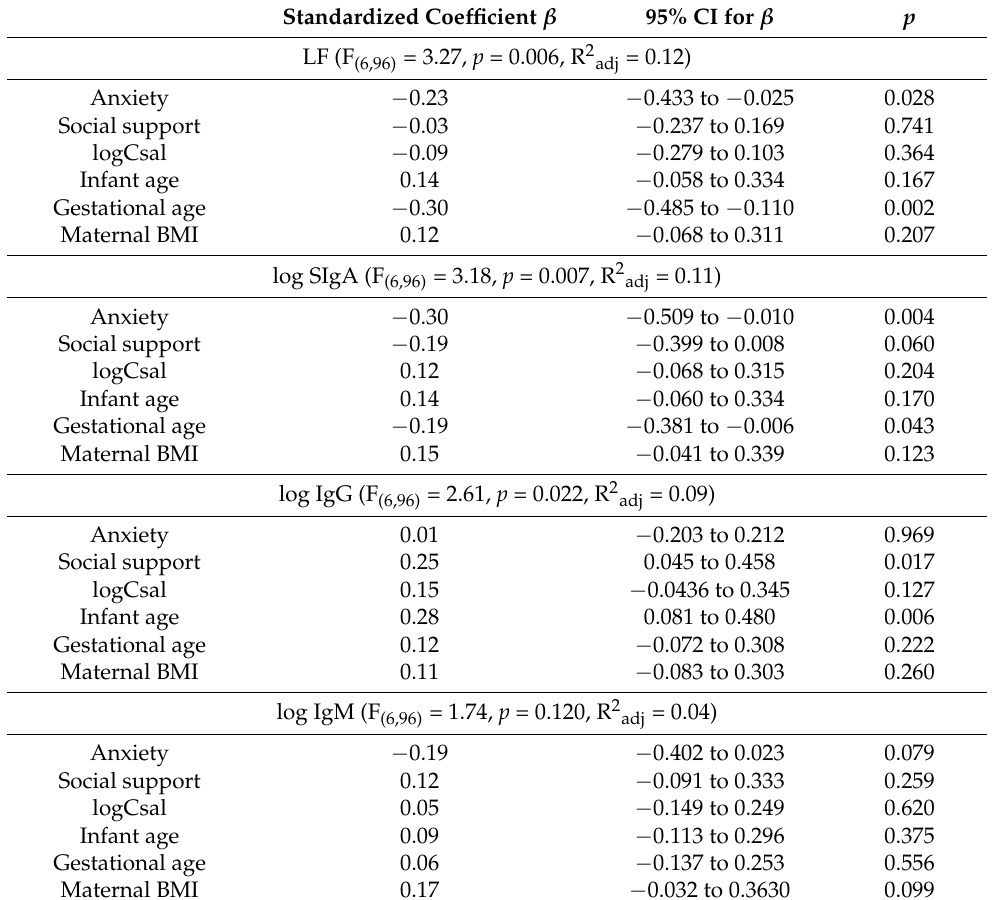
Table 2. Results of the regression models for the association between maternal distress (anxiety, logCsal), social support, and levels of milk LF, SIgA, IgG, and IgM. Standardized Coefficient β 95% CI for β